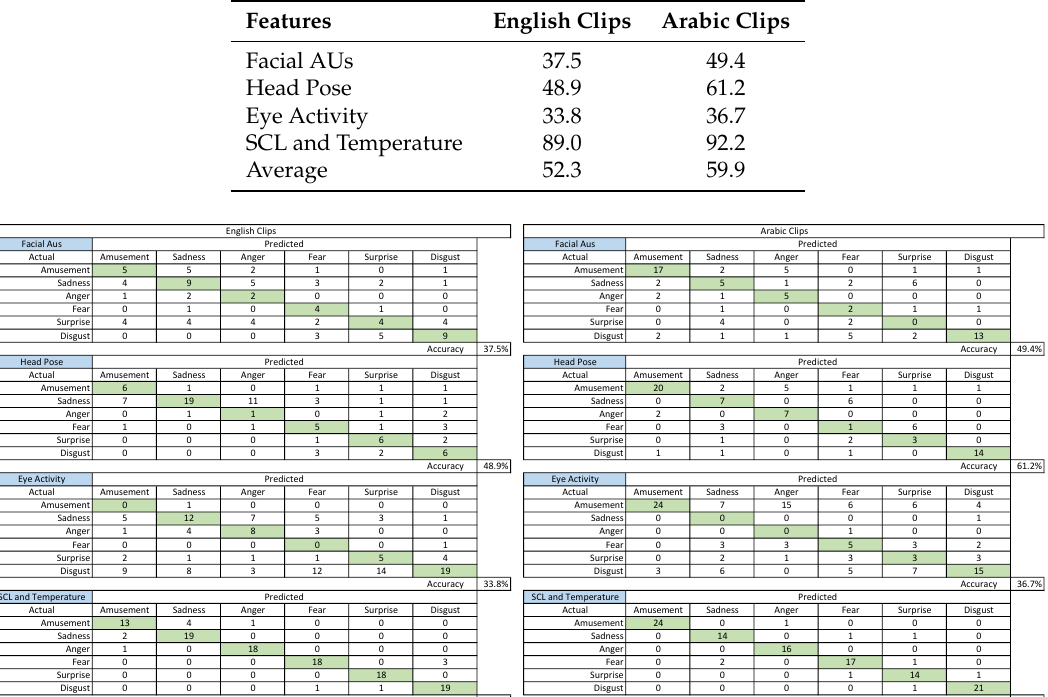
Table 8. Classification accuracy (in %) for the 6 elicited emotions from English and Arabic clips.